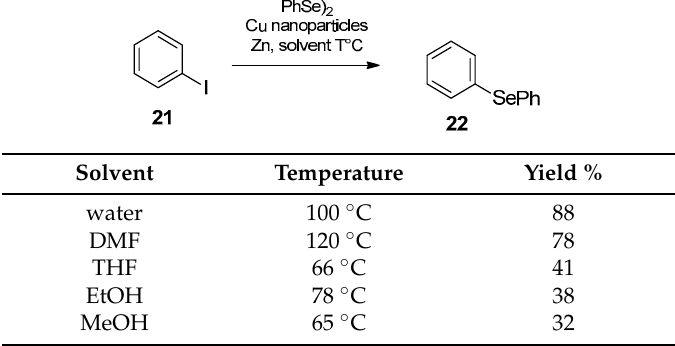
( b ) Figure 16. ( a ) Synthesis of the bisselenide 29 ; ( b ) Reuse of the catalyst in the reaction of 4-iodoanisole and diphenyl diselenide. Very recently it was reported by Alves et al. that the solvent can also selectively direct the selenenylation of terminal alkynes toward the formation of mono-selanyl alkenes when the reaction is performed in solvent-free conditions, or bis-selanyl alkenes when the reaction is performed in water [63]. Among organocatalytic reactions, pyrrolidine has been used to catalyze a [3 + 2] cycloaddition of aziridines with isoselenocyanates using water as a reaction medium at 50 °C, producing the corresponding selenium-containing heterocycle in good to excellent yields [64]. Finally, an aqueous NaOH solution has recently been used for the synthesis of spirocyclopropyl oxindoles through a domino Michael/intramolecular nucleophilic substitution sequence using different combinations of substituted vinyl selenones and enolizable oxindoles [65], as well as for the